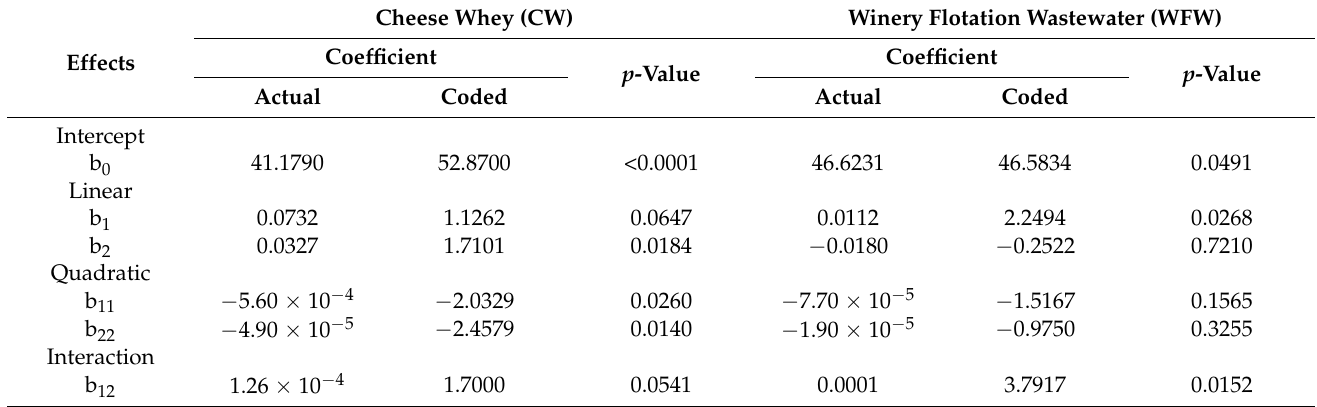
Table 8. Coefficients of regression equations for inhibition zone